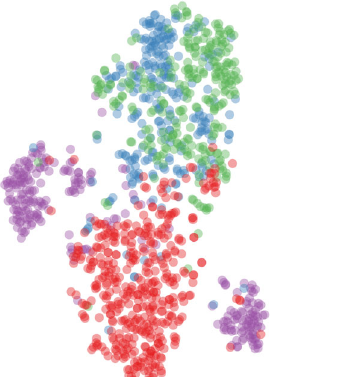
Fig. 6 Mode classi fi cation for four modes in the Renaissance epoch according to the Bayesian model. The clustering reveals one distinct mode (red), two very similar modes (blue, green), and another mode distinct from the others (violet). Note that the latter is separated into two subclusters after dimensionality reduction. In the original mode space, the pieces in the two violet clusters are all close to each other.